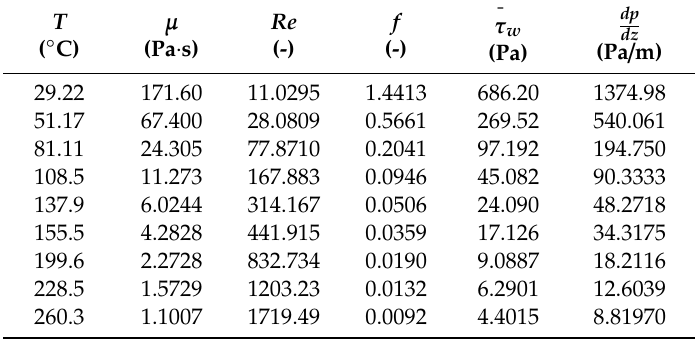
Table 4. Values of the fluid dynamic parameter obtained in the simulations with β = 0.02 and N = 8.